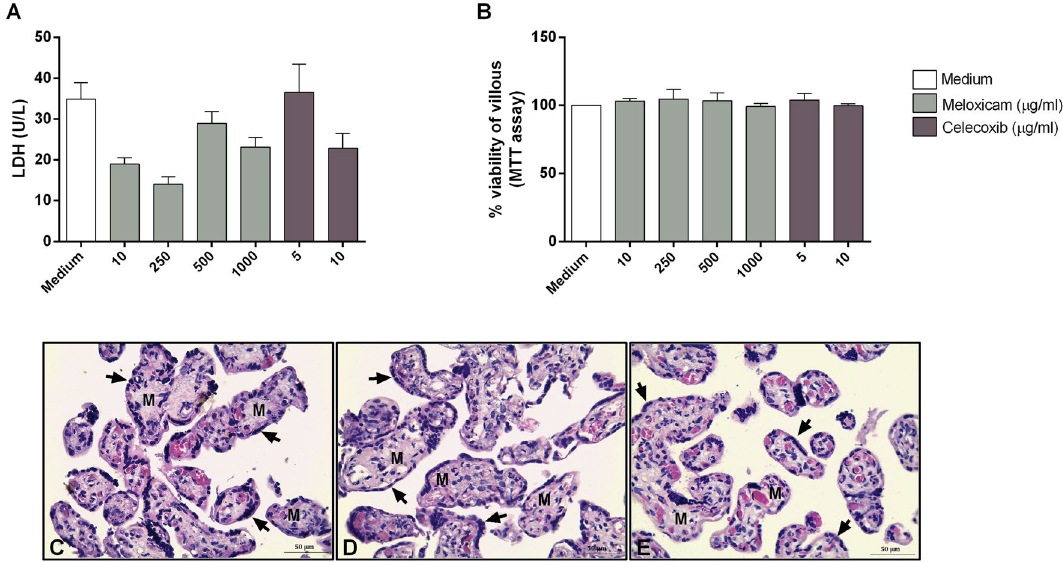
Figure 7. Viability of human villous explants treated with COX-2 inhibitors. Villous explants were treated with meloxicam or celecoxib for 24 h. Next, the supernatants were collected and lactate dehydrogenase (LDH) activity was measured ( A ) and villous explants were analyzed by MTT assay ( B ), and tissue viability was expressed in percentage (%) of villous viability in relation to untreated villous (medium, 100% of villous viability). Data were shown as mean ± SEM from two independents experiments with eight replicates. Differences between groups were analyzed by One-Way ANOVA test with Sidak’s multiple comparison post-test ( A ) or Kruskal–Wallis test and Dunn’s multiple comparison post-test ( B ) (GraphPad Prism Sofware version 6.01, https:// www. graph pad. com). Representative photomicrographs of untreated villous explants ( C ), or treated with meloxicam ( D ) or celecoxib ( E ). Histological sections stained by Harris-hematoxylin and eosin. Arrows indicate the syncytiotrophoblast layers and M indicate the mesenchyme. Bar scale: 50.0 which it is possible to observe that the lower concentration of meloxicam ( $ P < 0.0001) or celecoxib ( % P = 0.0491) reduced LDs production in a dose-dependent manner (Fig. 6B). Representative photomicrographs are shown in BeWo (Fig. 6C–H) and HTR-8/SVneo cells (Fig. 6I–N). Uninfected and untreated (Fig. 6C,I), infected and untreated (Fig. 6D,J), infected and treated with meloxicam 10 μg/mL (Fig. 6E,K), 250 μg/mL (Fig. 6F,L), or infected and treated with celecoxib 1 μg/mL (Fig. 6G,M), 5 μg/ mL (Fig. 6H,N). Thus, the COX-2 inhibiton decreased the LDs production in both cells infected by T. gondii . COX‑2 inhibitors were not toxic and reduced the T. gondii intracellular proliferation in human villous explants. After evaluating the effects of COX-2 inhibitors in in vitro models, we evaluated the influ- ence of COX-2 inhibitors in human villous explants, an ex vivo model of maternal–fetal interface (Fig. 7). Firstly, based on the measurement of the LDH enzyme, we observed that no concentration of both inhibitors changed the villous viability (Fig. 7A). Additionally, we performed the MTT assay and observed the same effect (Fig. 7B). Based on these data, we chosed the concentration of 250 μg/mL meloxicam and 5 μg/mL celecoxib for further ex vivo experiments. Representative photomicrographs of untreated villous (Fig. 7C), or villous treated with 250 μg/mL meloxicam (Fig. 7D) or 5 μg/mL celecoxib (Fig. 7E), where it is possible to observe the morphology of the syncytiotrophoblast (arrow) and mesenchyme (M) preserved when compared to untreated villous (medium). Next, we evaluated the effect of COX-2 inhibitors in T. gondii intracellular proliferation. We observed that meloxicam (250 μg/mL: * P = 0.0030) and celecoxib (5 μg/mL: * P = 0.0043) decreased the parasite replication when compared to untreated villous ( T. gondii ) (Fig. 8).